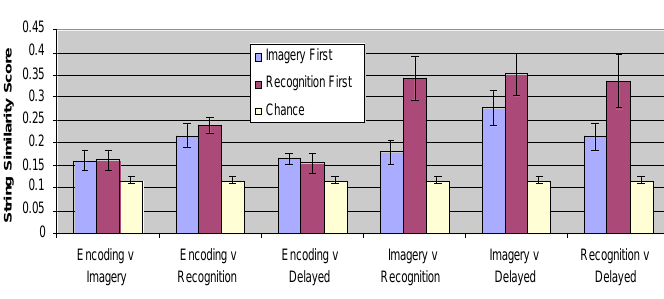
Figure 10: Differences in string similarities between The Imagery First group and The Recognition First group and between string comparison types.